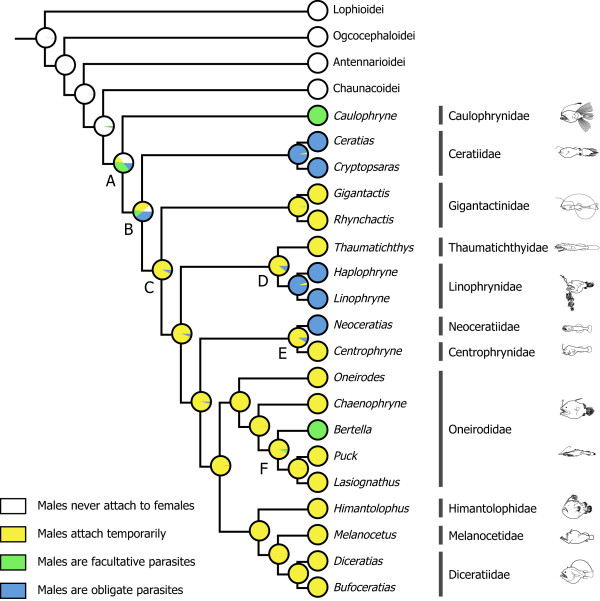
Maximum likelihood reconstruction of the male sexual parasitism in ceratioid anglerfishes. Four discrete character states were assigned to each terminal and ancestral character states were reconstructed on the ML tree (Figure 5) under an ML optimality criterion using Mesquite ver. 2.6 [56].